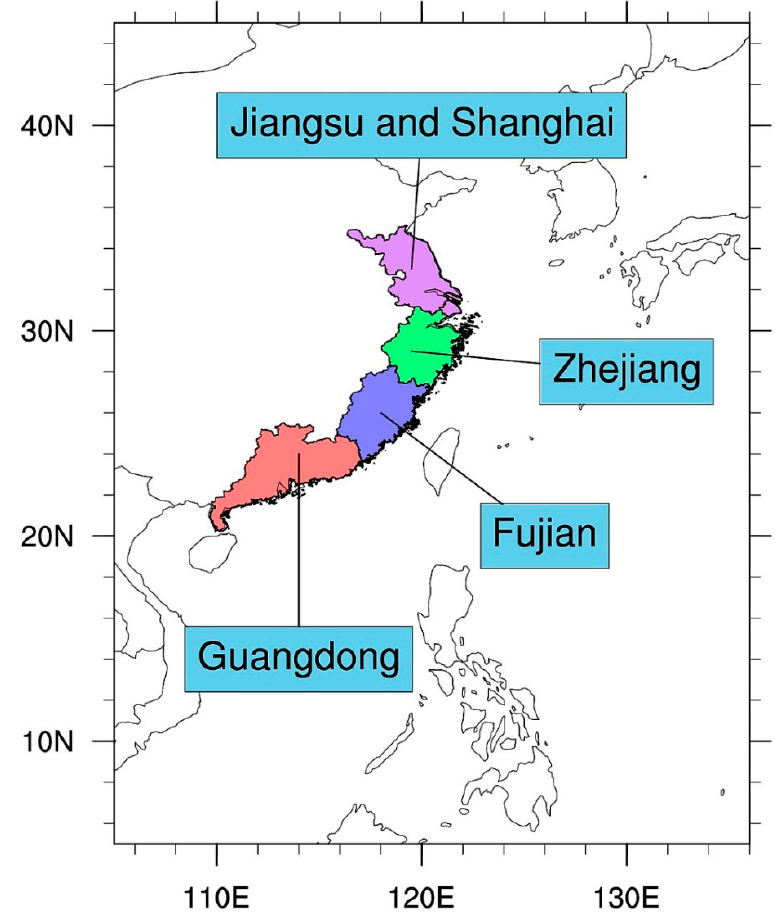
Figure 1. Geographic locations of the region of interest in this study.